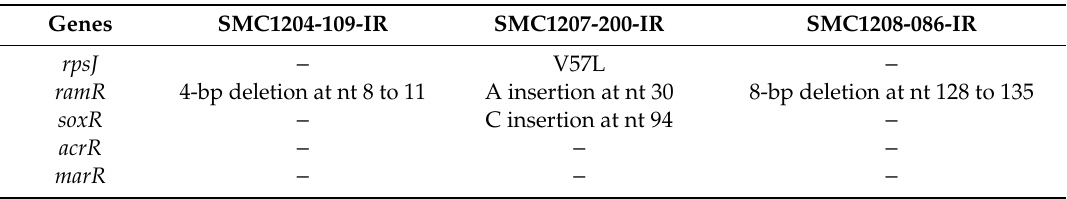
Table 3. Mutations in the rpsJ gene and transcription regulator genes in TGC-IR mutants compared with that of their parental TGC-S strains.